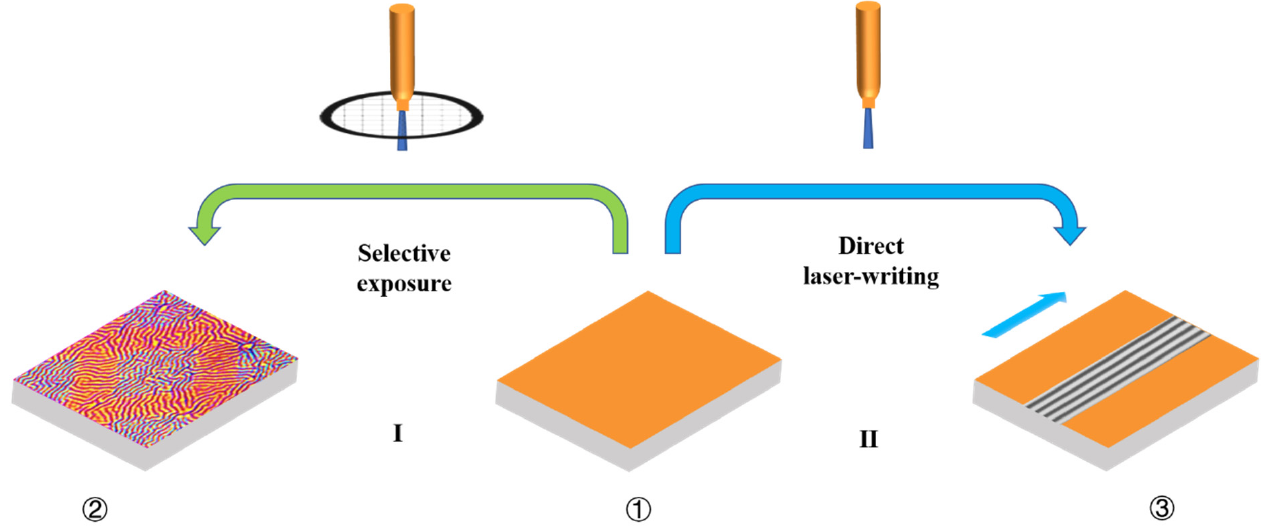
Figure 2. Schematic illustration of all-optical surface patterning strategy. Wrinkles with different morphology ( ② ) and uniaxially oriented wrinkles ( ③ ) are induced by exposing the (PDO 3 -PS)/PDMS bilayer ( ① ) to a high-intensity 450 nm laser light with a photomask (route Ⅰ ) or a high-intensity moving laser beam (route Ⅱ ).